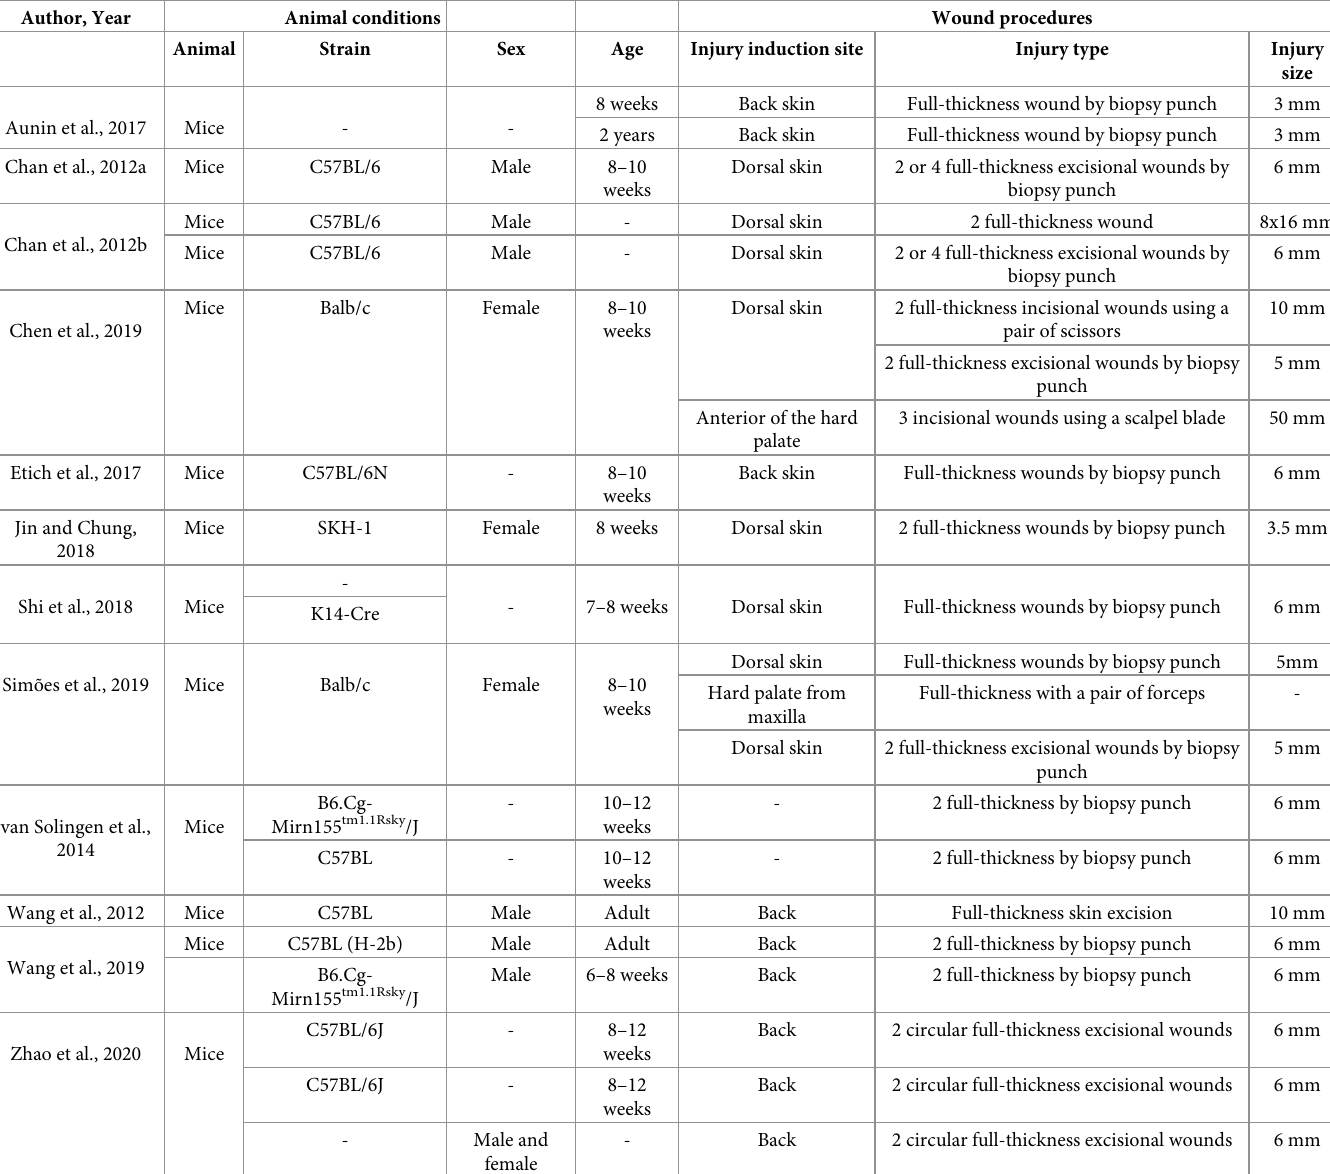
Table 1. Correlation of the main methodological approaches found in the selected